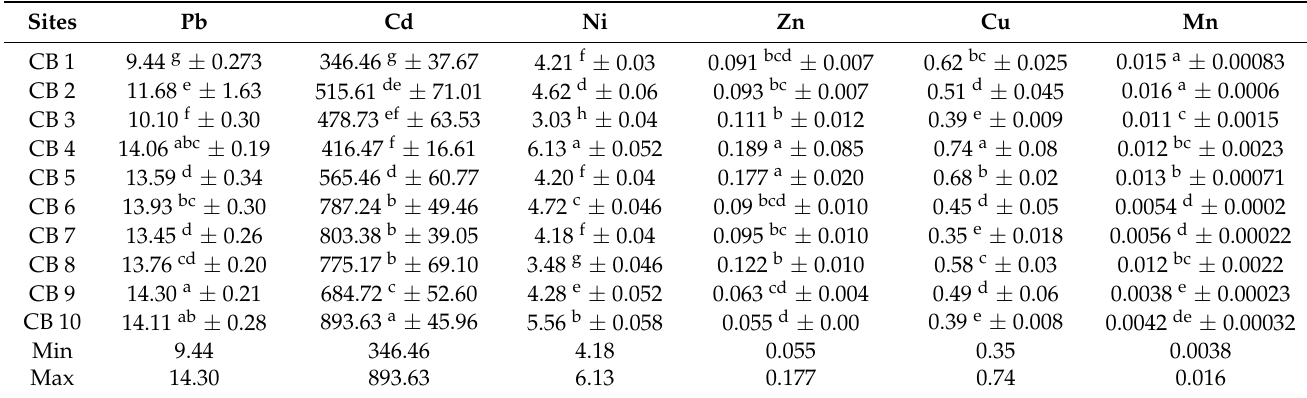
Table 6. Potential ecological risk index (PERI) of heavy metals for all sediment samples of Chalan beel area. Sites Pb Cd Ni Zn Cu Mn